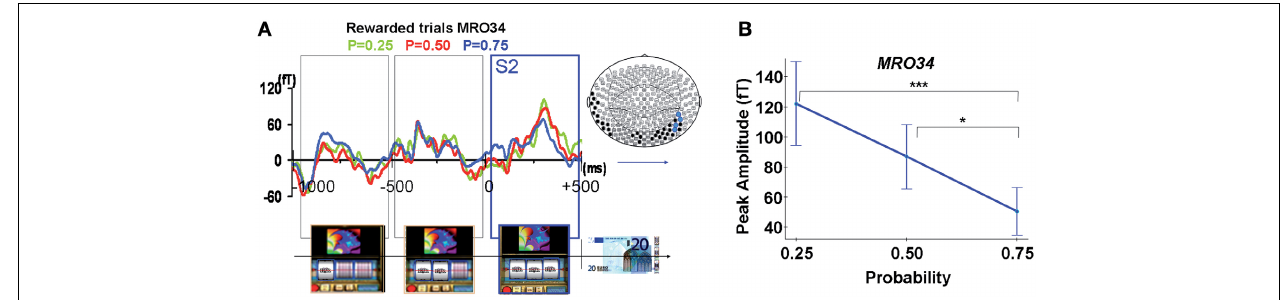
FIGURE 4 | MEG response occurring during spinner’s rotations and at the time of the outcome S2. (A) Averaged signal from a representative selected occipital site (sensor MRO34), during spinners’ rotation and showing a linear modulation with reward probability when the third spinner stopped (S2) for rewarded trials (Reward probability P = 0 . 25: green; P = 0 . 5: red; P = 0 . 75: blue). Color dots on the map’s brain indicate sensors where there was a statistical difference